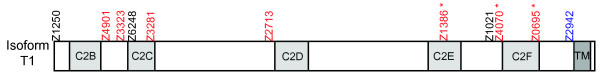
Location of mfr mutations on testis protein isoform T1. Locations of amino acid changes resulting from missense mutations are noted in black. Locations of protein truncations resulting from nonsense mutations are noted in red. The position of an altered exon predicted by a splice site mutation is noted in blue. Location of mutations that affect egg patterning are noted with a "*".